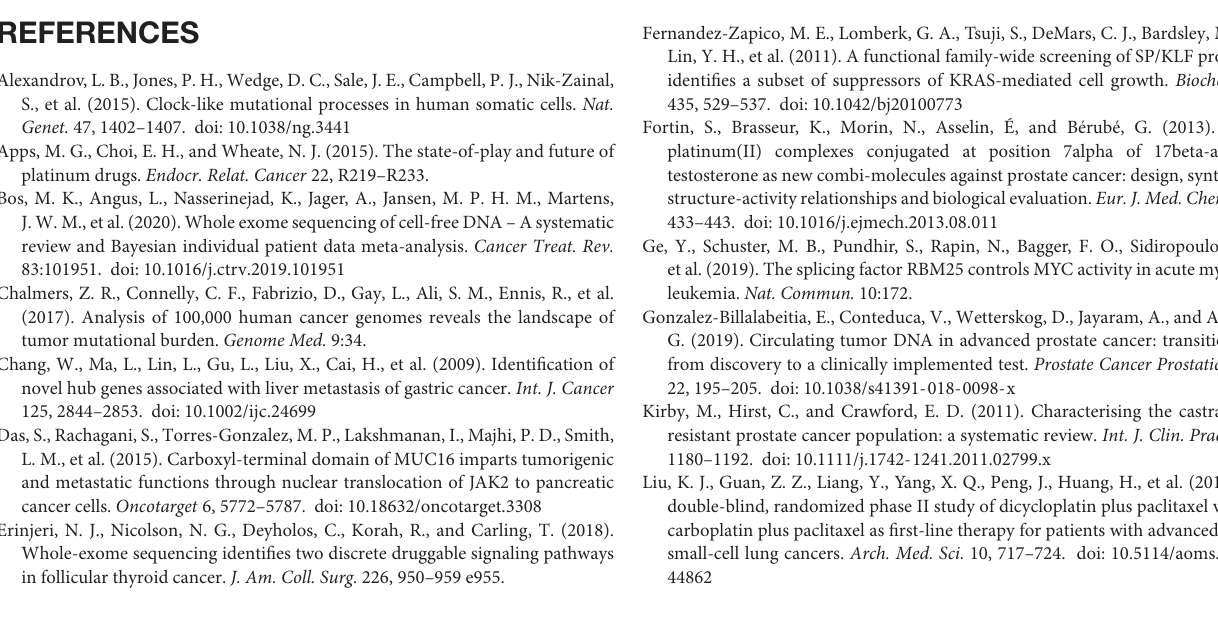
Supplementary Figure 1 | Dynamics of PSA and free PSA (fPSA) of patients during treatment course. PSA (A) and fPSA (B) levels were decreased in 6 PR patients and 3 CR patients, were increased in 6 PD patients and 1 SD patient. Supplementary Figure 2 | Mutational landscape of selected genes associated with tumor and platinum metabolism. (A) Oncoplot of the top 20 mutated gene in dicycloplatin-treated samples. The percentages and the bar plots on the right represent the fraction and the number of samples with variations in the corresponding gene. (B) Differentially somatic mutated genes between dicycloplatin-sensitive group and dicycloplatin-resistant group. The dots and horizontal bars denote the hazard rate and 5–95% CI. ∗ P -value < 0.05. NS: not significant. Supplementary Figure 3 | Comparison of 30 cosmic signatures between dicycloplatin-sensitive and dicycloplatin-resistant